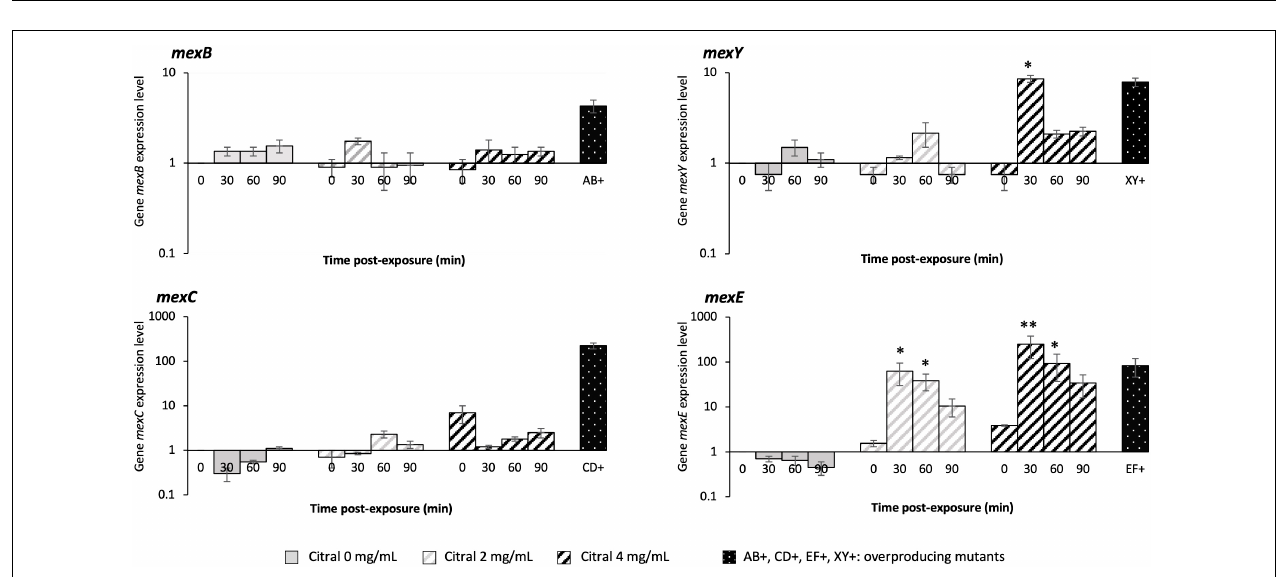
FIGURE 1 | Effect of increasing citral concentrations on P. aeruginosa reference strain PA14. Bacterial growth in MHB supplemented with different concentrations of citral (0, 1, 2, 4, and 8 mg/mL) was monitored at A 600 nm over 5 h. The results presented are mean values, calculated from three independent bacterial cultures.